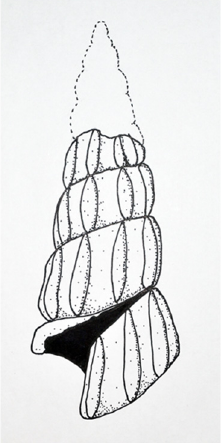
Figure 13. Abyssochrysoid gastropod (IGM 5010b). Reconstruction of complete shell. Note last whorl separating from previous whorls. Greatest dimension of preserved shell: 4.0 mm.